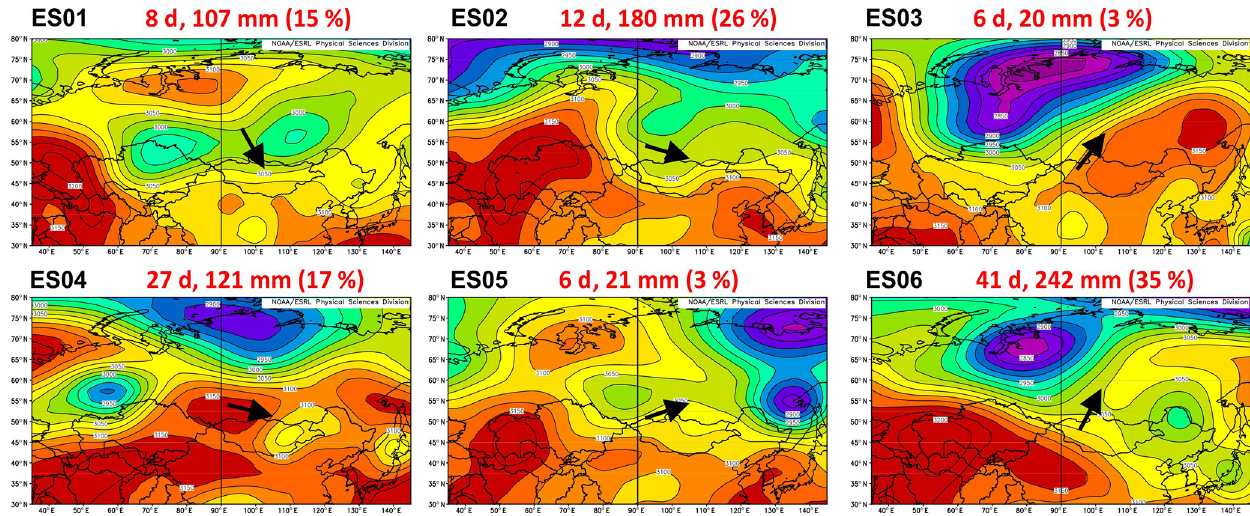
Figure 6. Synoptic patterns allocated for days with precipitation on the glacier (maps of 700hPa surface). For each type, the duration (in d) and total amount of precipitation (in mm and %) are indicated. Black arrows indicate leading airflows in low troposphere (700hPa level) over the study